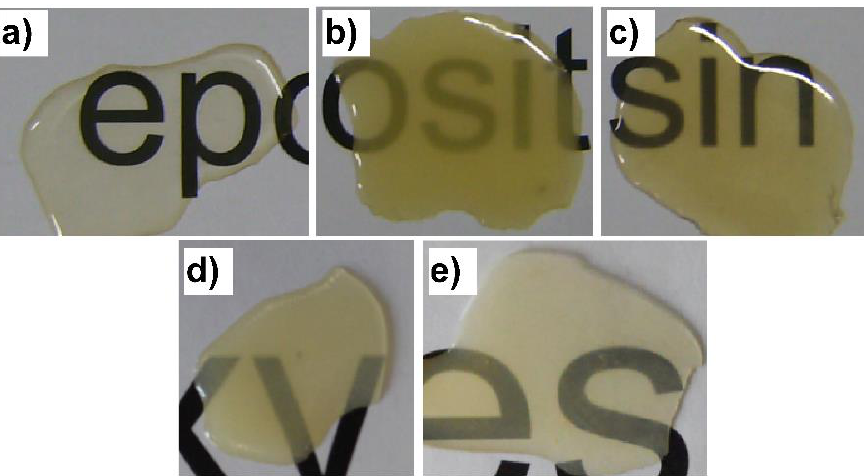
Figure 3. Pictures of nanocomposite plates containing (each 5 wt%) unmodified larger silica and zirconia nanoparticles ( a ) blank epoxy resin, ( b ) unmodified ZrO 2 , ( c ) DEG-PPA@ZrO 2 , ( d ) larger SiO 2 unmodified, ( e ) larger Gly-TMeOs@SiO 2 . Images ( a – c ) were reproduced with permission of John Wiley & Sons Ltd. (Hoboken, NJ, USA) from a previous publication for reasons of comparison [24].